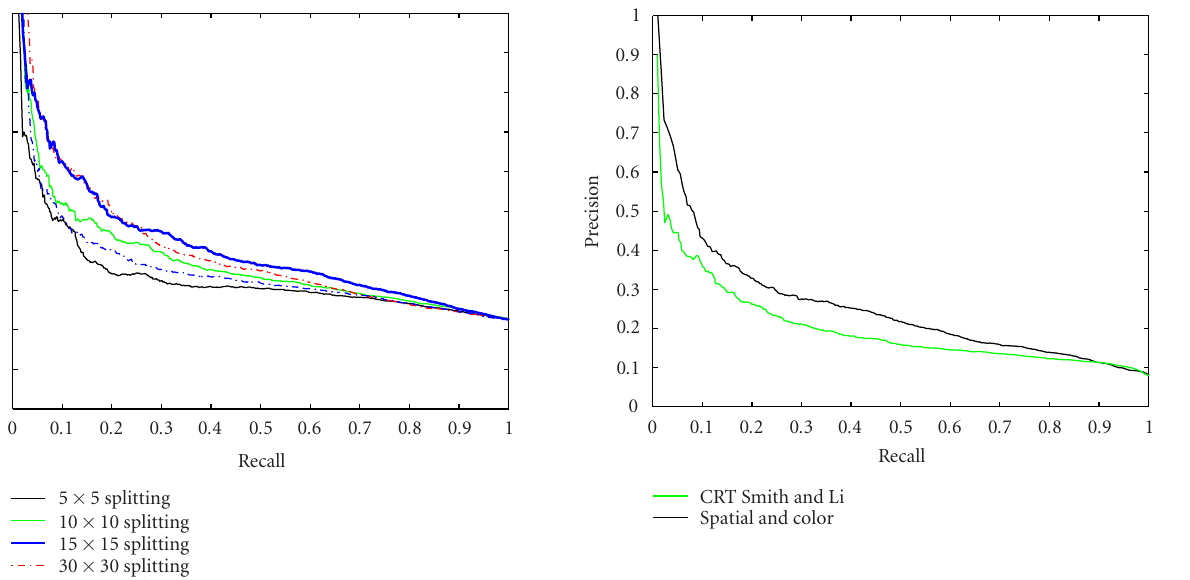
Figure 8: Precision/recall curves using the Smith and Li signature and our spatio-colorimetric signature (elephant